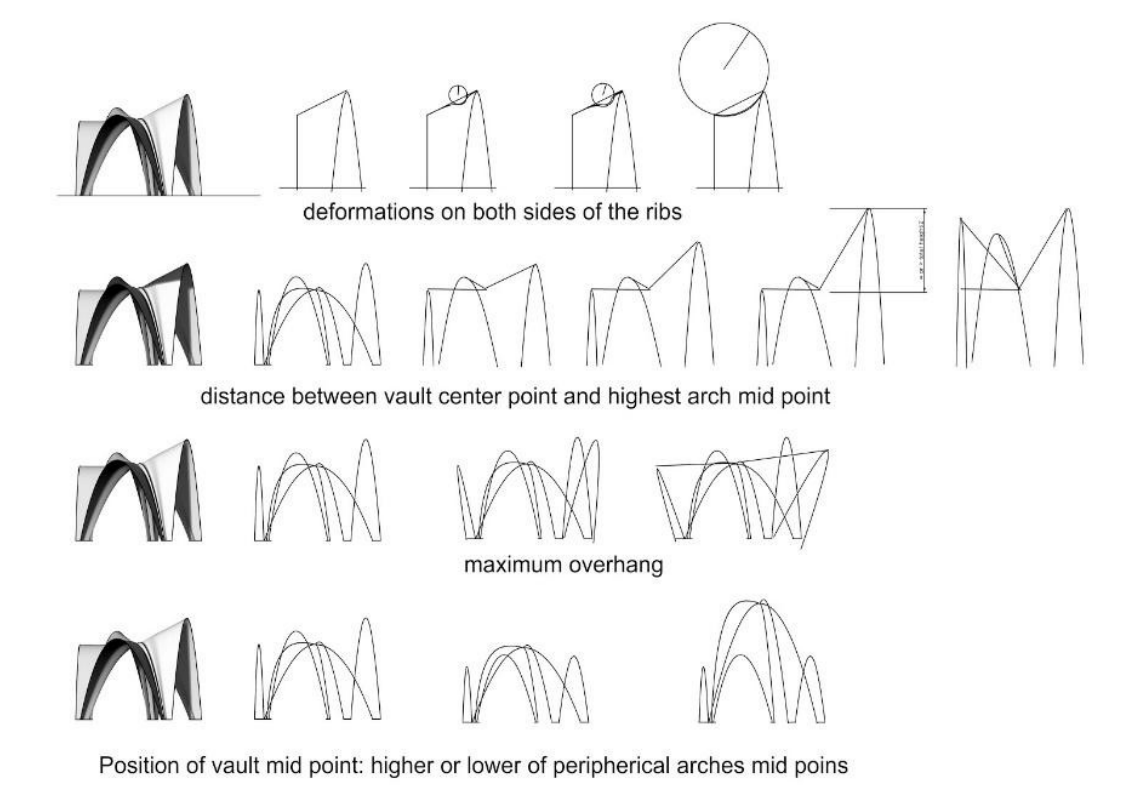
Figure 4. Diagram of considerations to determine viable geometry ranges: maximum sagging, maximum distance between lower and higher arch (convex and concave resulting surfaces) and maximum overhang. By the